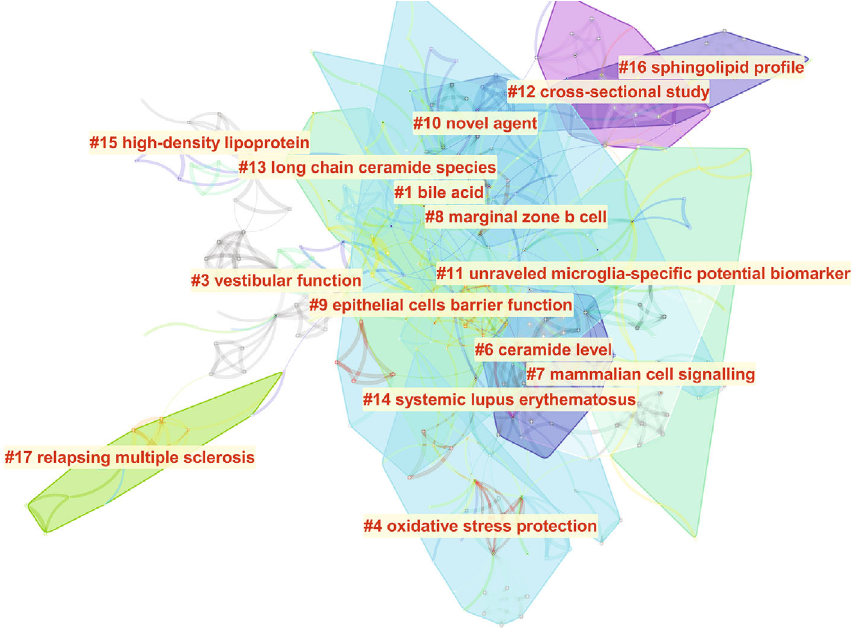
Figure 7: Keywords cluster map describing the hot spots in S1P age-related